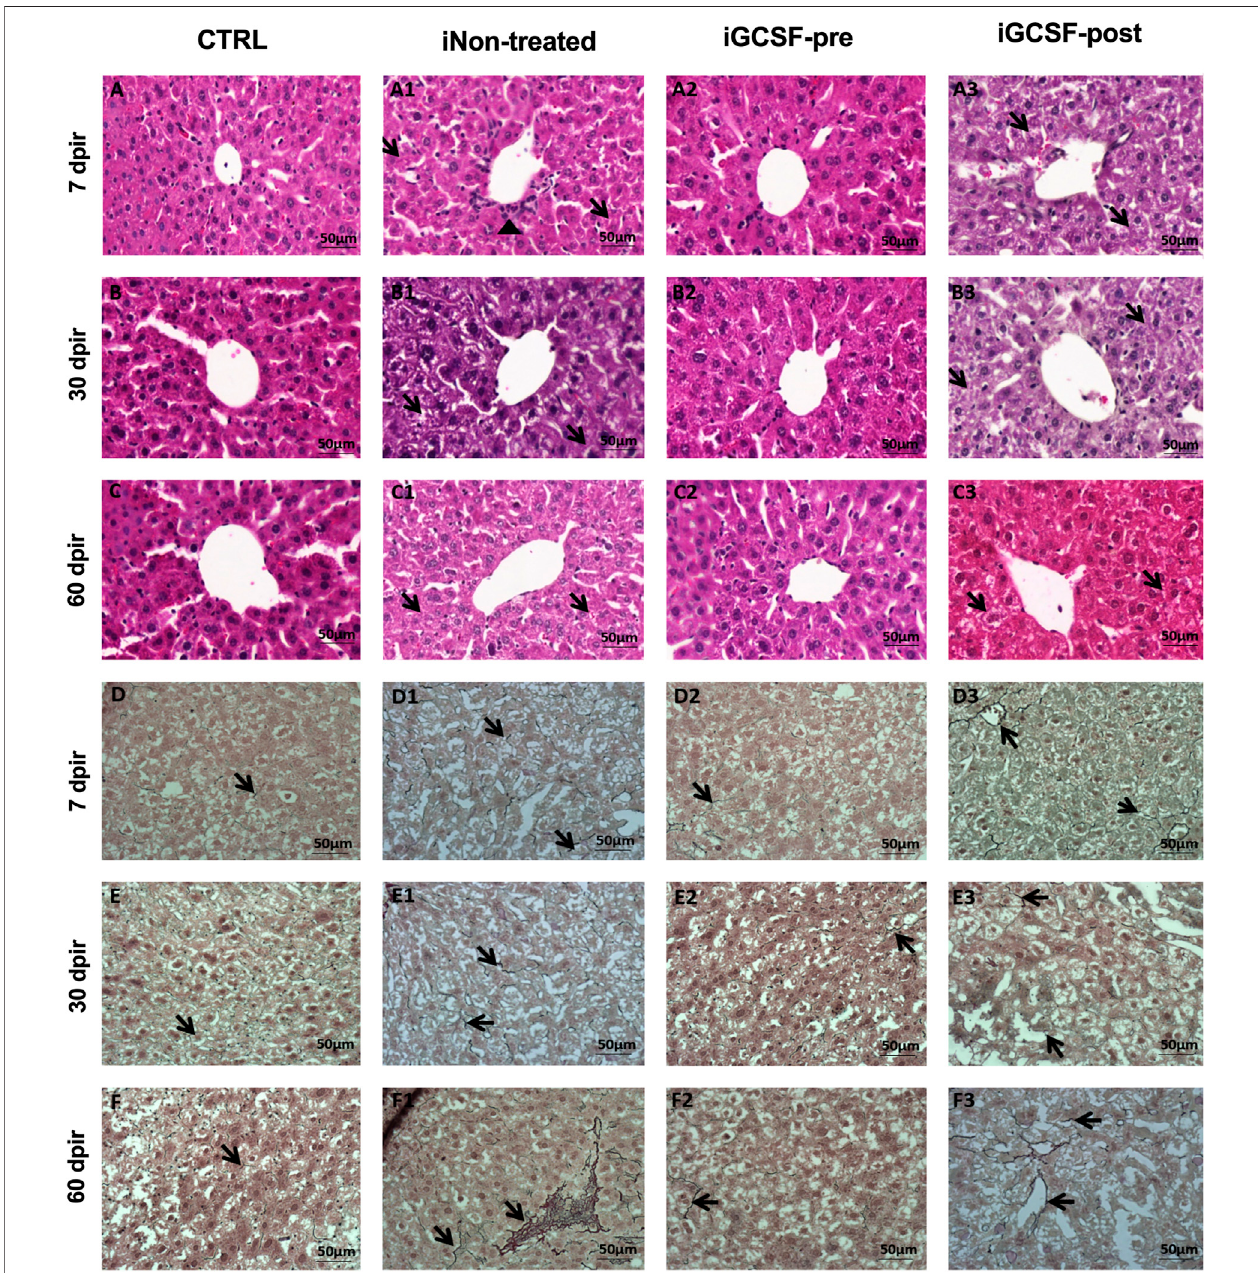
FIGURE6| Histopathologicalassessmentoflivertissue.Representativeimagesstainedwithhematoxylinandeosin(H&E)and reticulinofCTRL (A – C;D – F) ,iNon- treated (A1 – C1,D1 – F1) , iGCSF-pre (A2 – C2,D2 – F2) and iGCSF-post group (A3-C3; D3-F3) at 7, 30- and 60-day post-irradiation. CTRL Group (A – C) H&E-stained sectionsrevealedliverparenchymawitharadialdistributionofhepatocytesaroundthevesselsandhomogeneousdistributionofcytoplasm.IntheiNon-treatedGroup,in 7 dpir (A1) the loss of the radial distribution of hepatocytes, beginning cytoplasm vacuolization (indicated by arrows) and polymorphonuclear in fi ltrate (indicated by arrowhead) was observed. At 30 dpir (B1) , most hepatocytes had vacuolization of the cytoplasm and did not show radial distribution around the vessel. At 60 dpir (C1) radial distribution was observed, but hepatocytes showed vacuolated cytoplasm (indicated by arrows). A preserved liver parenchyma with a radial distribution of hepatocytes and absence of cytoplasmic vacuolization (indicated by arrows) of hepatocytes were observed in iGCSF-pre (A2 – C2) group at 7, 30 and, 60 dpir. In the iGCSF-post (A3 – C3) group,hepatocytesshowedvacuolatedcytoplasm(arrows)andloss ofradialdistributionaroundthevesselatalltimesanalyzed.( n (cid:1) 8per group). In liver tissue impregnated with silver (Reticulin) histological sections, the CTRL group (D – F) showed the presence of few reticulin fi bers (indicated by arrows). iNon- treatedgroupimages (D1 – F1) showedanincreaseinthesereticulin fi bers(arrows)from7dpir (D1) to60dpir (F1) .IntheiGCSF-preGroup (D2 – F2) itwasobservedthat thetissuehadfewerreticular fi bers(arrows)thantheiNon-treatedGroup,butmore fi bers(arrows)werefoundthanintheCTRLgroup.IntheiGCSF-post Group (D – D2) , there was also an increase in fi bers (indicated by arrows) concerning CTRL ( n (cid:1) 8 per Group). Scale bars: 50 µm.